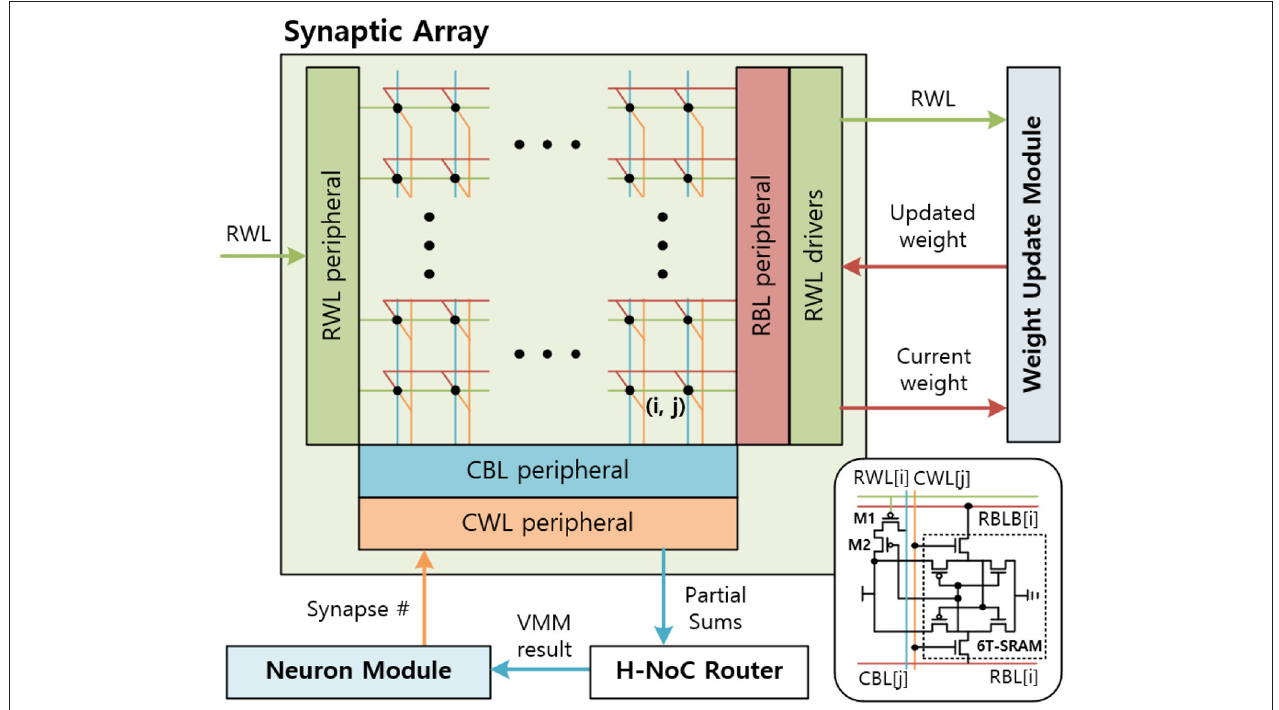
FIGURE 9 | The synaptic array architecture.